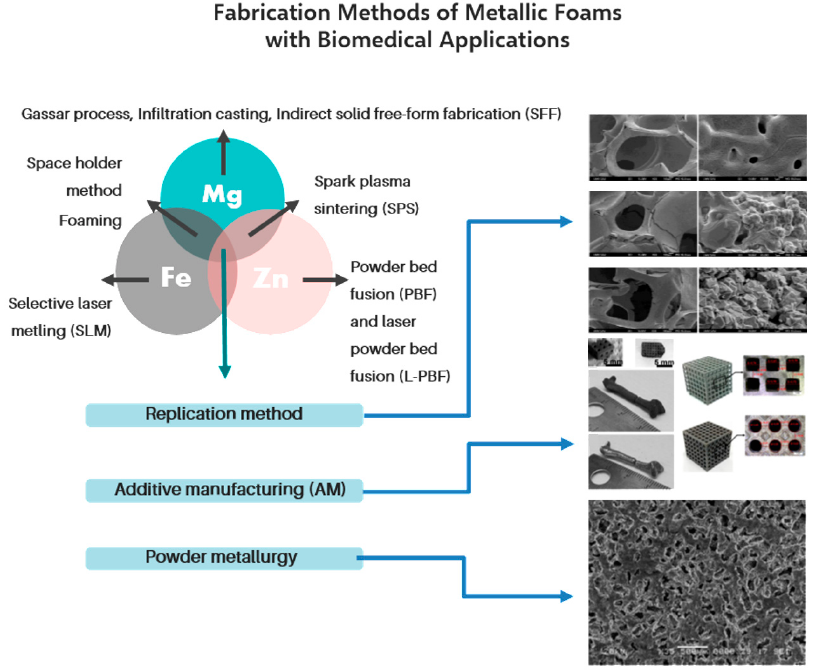
Figure 2. Schematic representation of the fabrication methods of metallic foam scaffolds with biomedical applications. Reprinted from Reference [13] and from References [34,52,62] with permission from Elsevier.